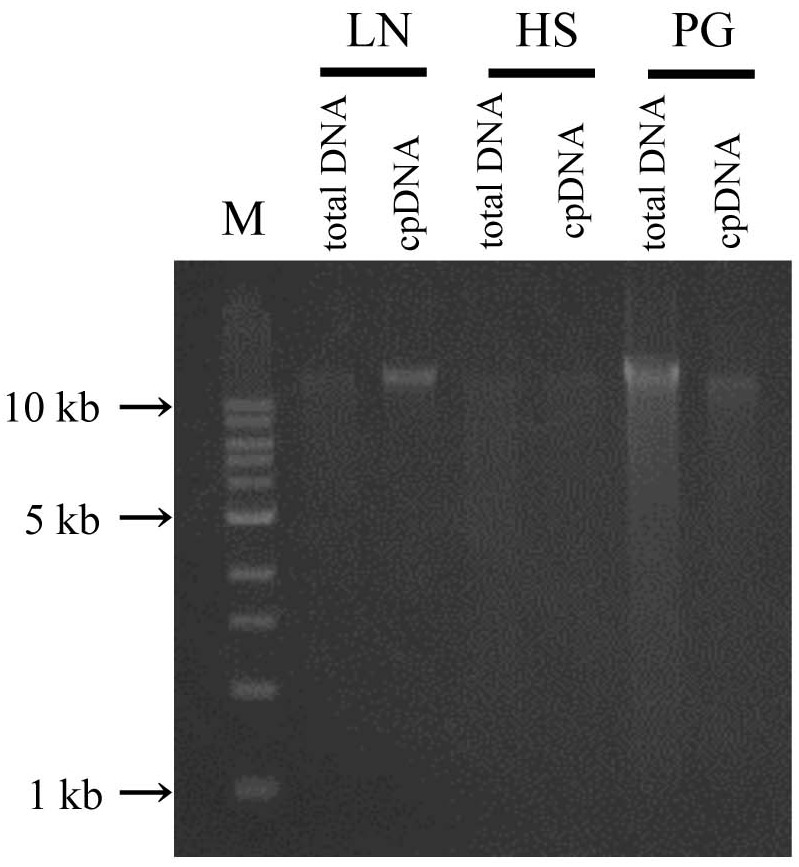
Chloroplast DNA visualization in agarose gel. Total DNA and cpDNA prepared by LN, HS, and PG protocols were subjected to 0.8% TAE agarose gel electrophoresis. M represents DNA size markers.